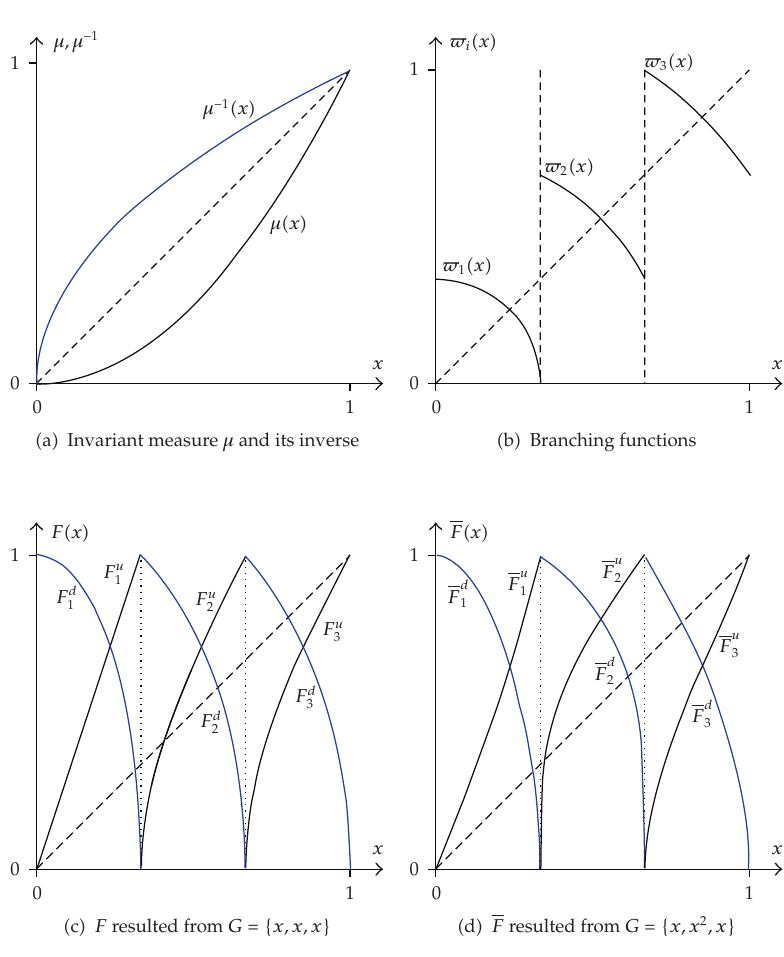
Figure 4: Illustration of Example